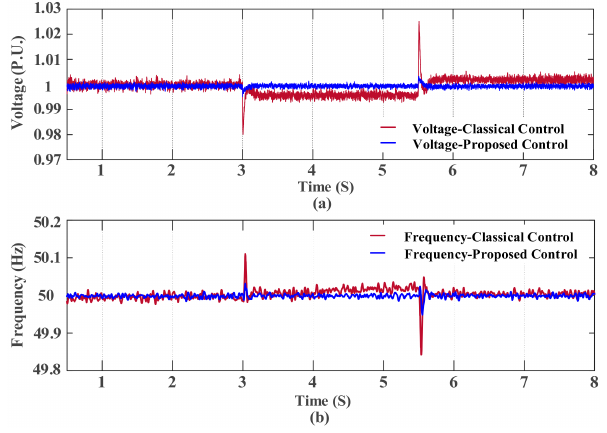
Figure 10. Restorations performance of secondary stage during balanced load change: ( a ) Voltage response; ( b ) Frequency response.